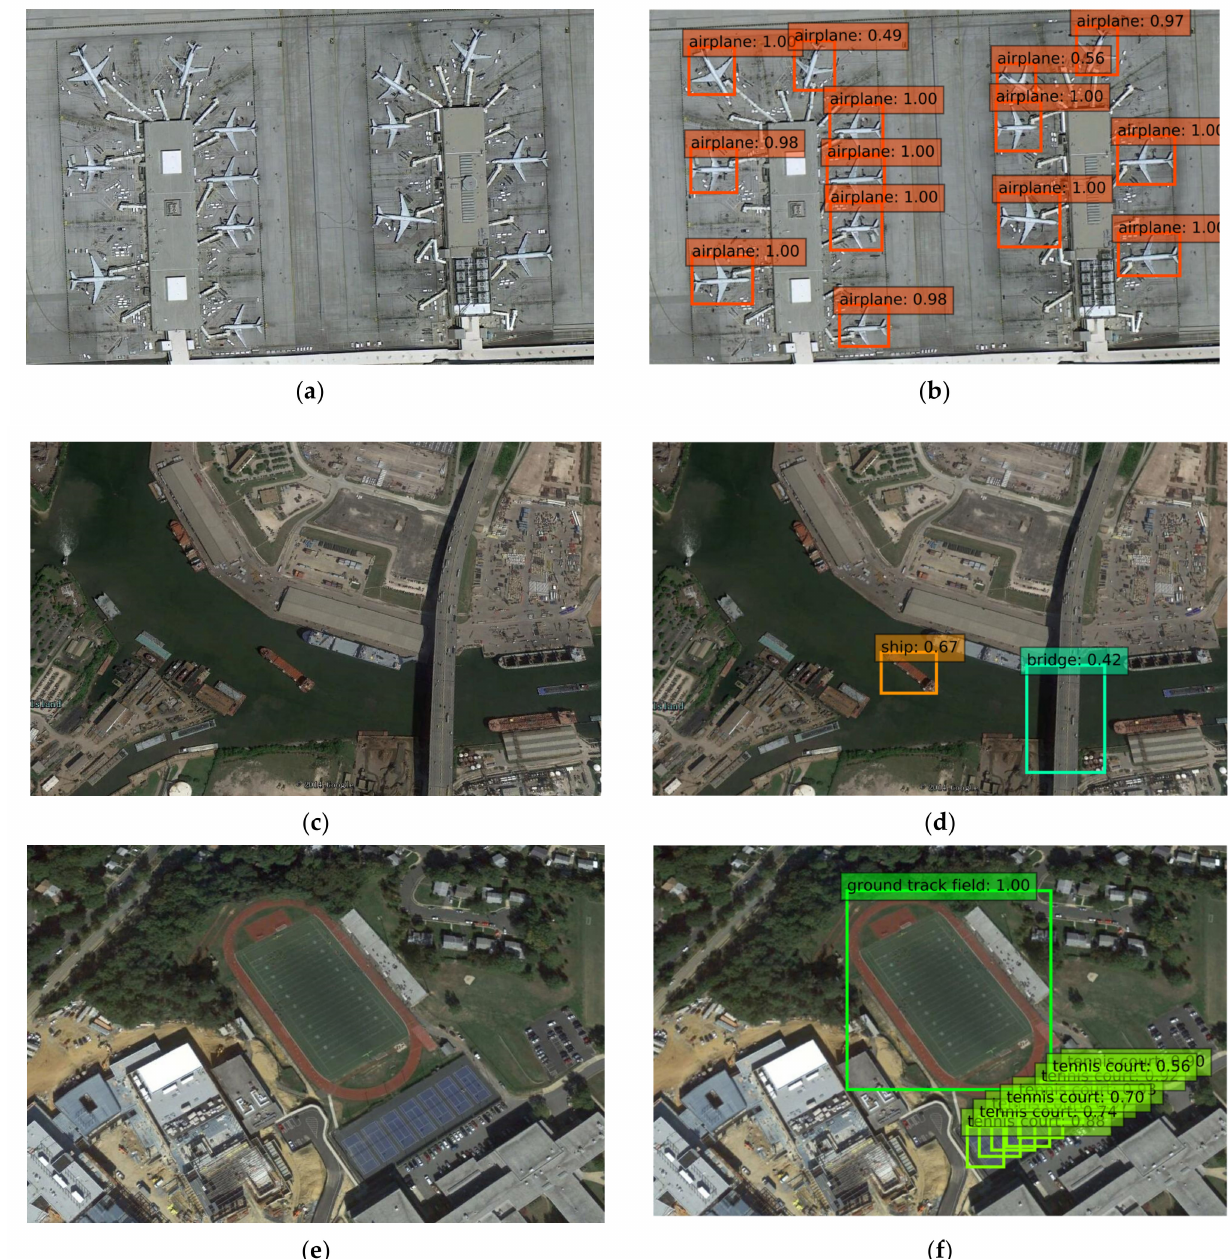
Figure 7. Qualitative detection examples on the NWPU VHR-10 dataset with the proposed SSD7-FFAM (83.7% mean Average Precision (mAP)). For each pair, the left ( a , c , e ) is the original image and right ( b , d , f ) is the result of the SSD7-FFAM. Each color corresponds to an object category in that